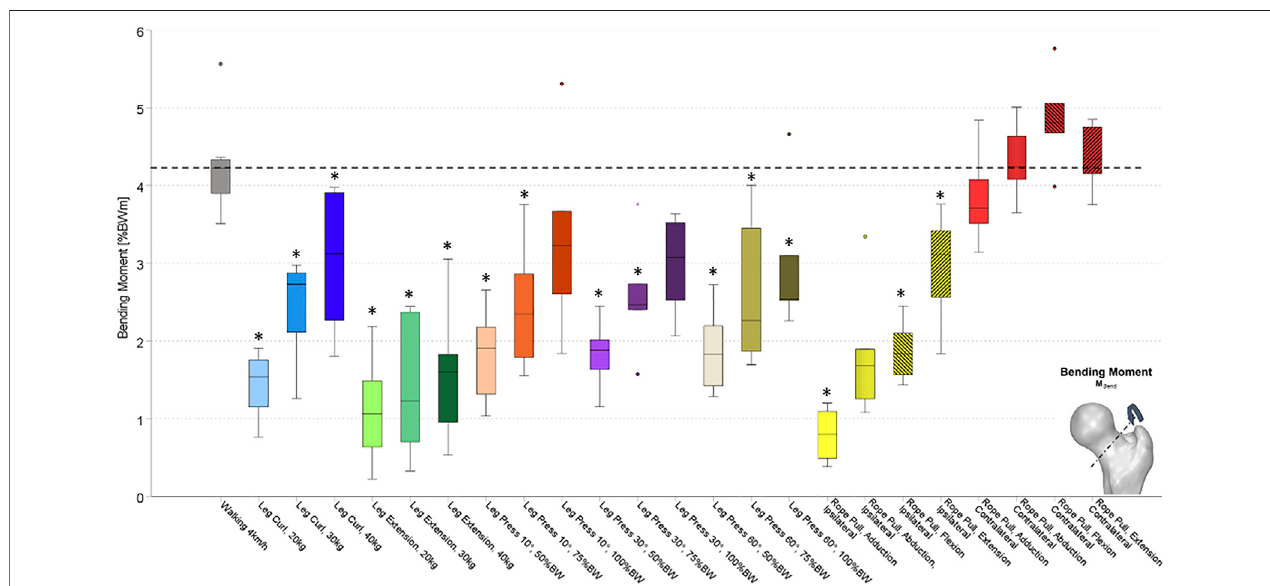
FIGURE 4 | Resultant torsion torques acting on the femoral stem (M tors ) while performing several activities on different training devices. Values were compared to walking as reference activity at a signi fi cance level of p ≤ 0.05. Signi fi cant differences to walking are marked with an asterisk (*). Exercises were performed at the leg curl and the leg extension machine with different load conditions (20, 30, and 40 kg), at the leg press machine with different load conditions (50, 75, and 100%BW) and a different inclination of the backrest (10 ° , 30 ° , and 60 ° ), and the rope pull machine with a load of 10 kg and hip adduction, abduction, fl exion, and extension on ipsilateral and contralateral leg. Ipsilateral and contralateral regarding the standing leg is either the implanted instrumented hip prothesis (ipsilateral) or the not operated side (contralateral). Rope pull exercises performed with ipsilateral side, standing on the contralateral leg referred to as ipsilateral. Rope pull exercises performed with contralateral side, standing on the ipsilateral leg referred to as